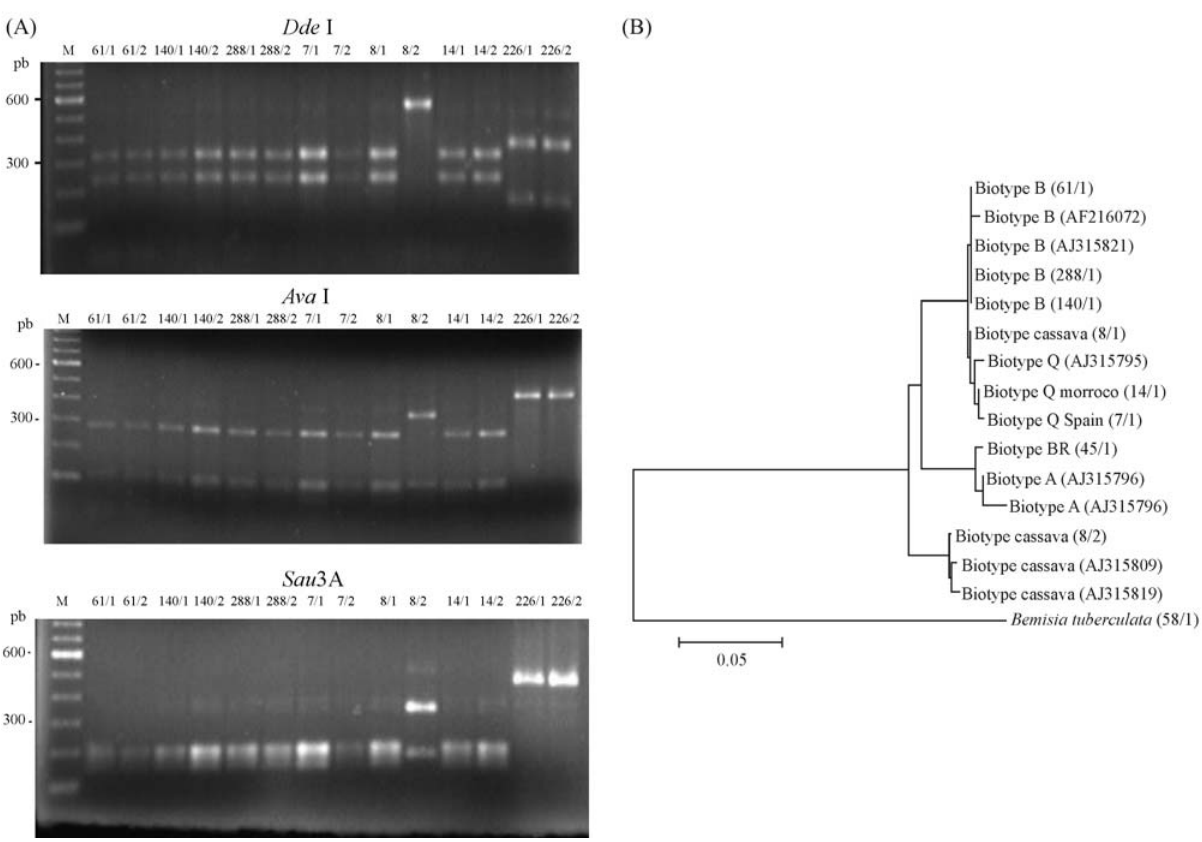
Figure 2 - A) Digestion of the Bemisia tabaci ITS1 rDNA region with the restriction enzymes Dde I (A), Ava I (B) and Sau 3A (C). 61, B biotype collect from melon (USA); 140, B biotype from soybean (Brazil); 288, B biotype collected from tomato (Brazil); 7, Q biotype (Morocco); 8, Cassava biotype (Nigeria); 14, Q biotype (Spain). B) Phylogenetic tree of the different Bemisia tabaci biotypes and populations listed in Table 1, with the bootstrap values over the branches. The tree was constructed using the Neighbor-joining method with MEGA version 3.0. The bar indicates the distance